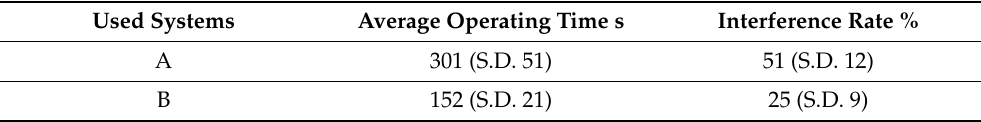
Table 4. Average operating time and interference rate with